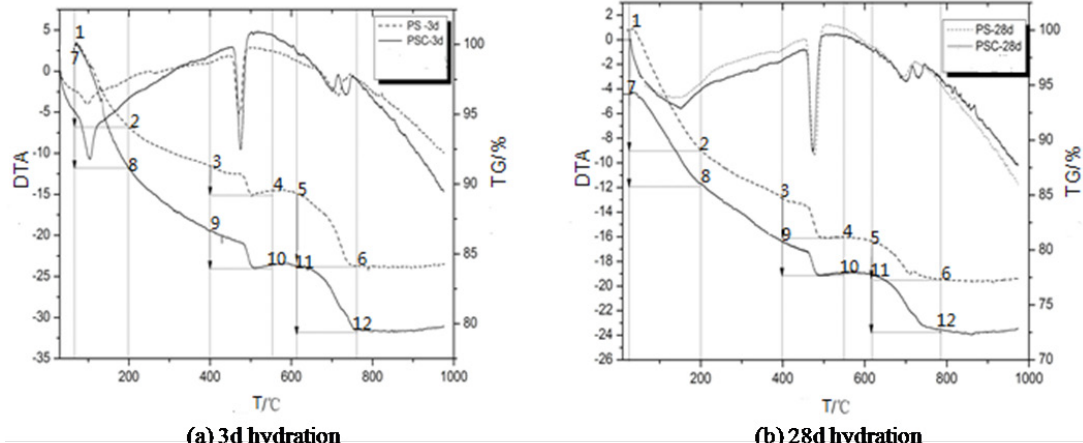
Fig. 6. TG-DTA patterns of PS and PSC hydrated for 3 and 28days(a and b,